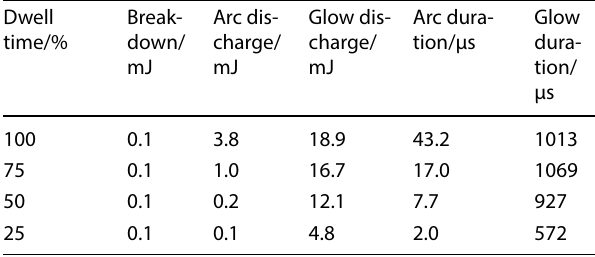
Table 2 Calculated electrical